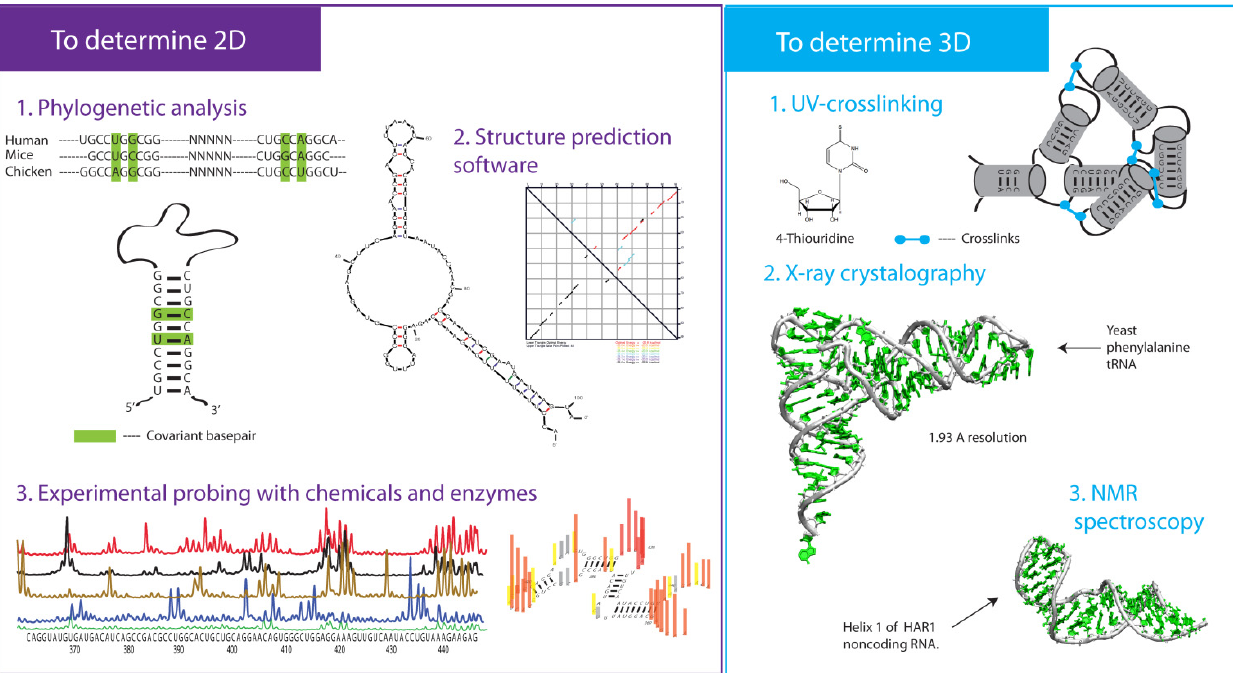
Figure 3. Summary of common strategies to tackle RNA structure. Left (purple), common approaches to determine the secondary fold of RNA. Right (blue), common methods to determine RNA tertiary fold. Adaptations of the crystal structure of tRNA and NMR structure of helix H1 of HAR1 are shown